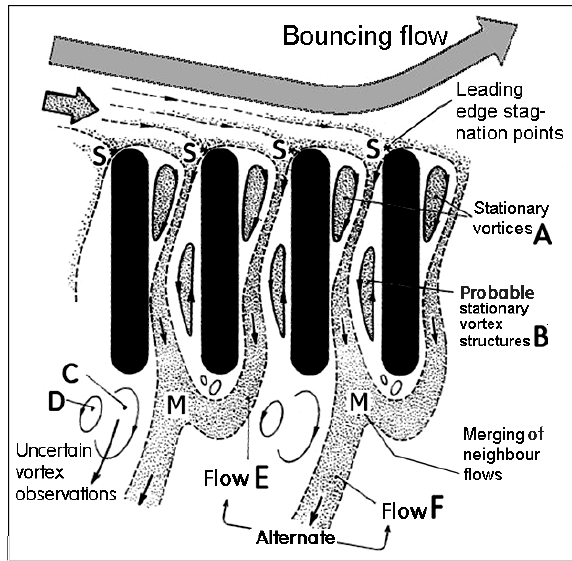
Fig. 20. Objects and flow configurations seen in photographs like the one in Fig. 19. Presence of the vortices B (in many flow visualisations not seen (cf. Fig. 19 above) were inferred from other aspects of the flow. Quite strange effect is the merging of a pair of neighbour flows at the blade’s trailing